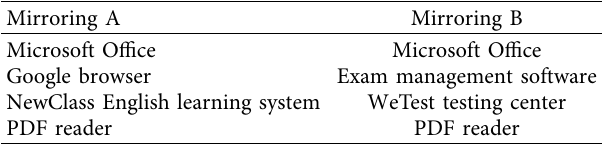
Figure 2: Software management in the intelligent classroom. Table 1: List of software installations in the intelligent